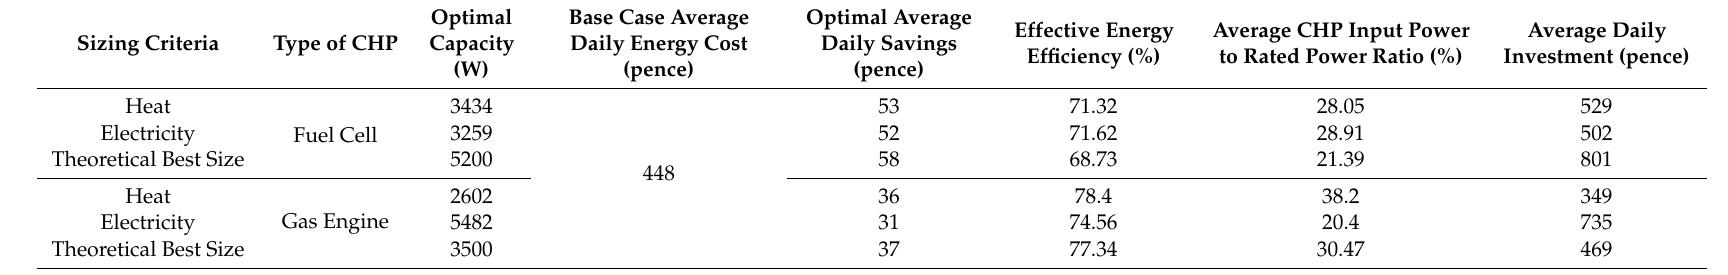
Table 4. A summary of the optimal results based on different CHP sizing